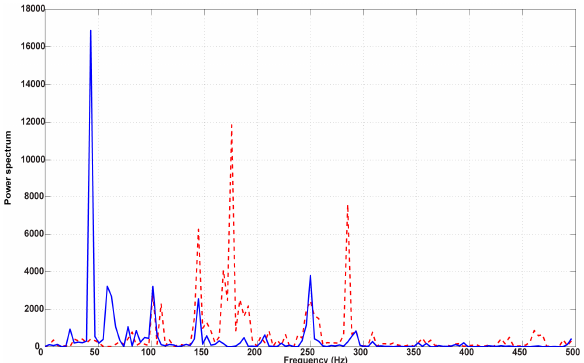
Figure 35. Spectrum comparison for the two vibration signals collected at the level of the wireless hub.